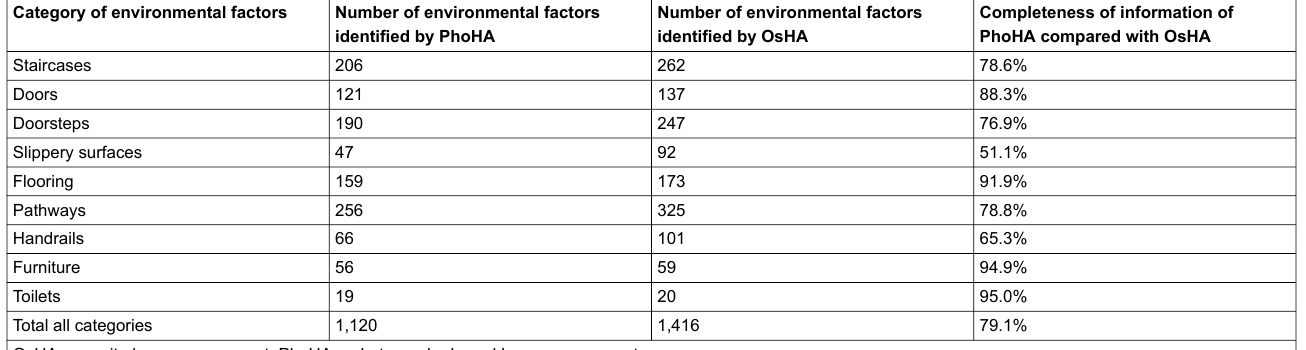
Table 1: Completeness of information obtained by the PhoHA compared with the gold standard (on-site home assessment) for the nine separate categories of environmental factors. Category of environmental factors